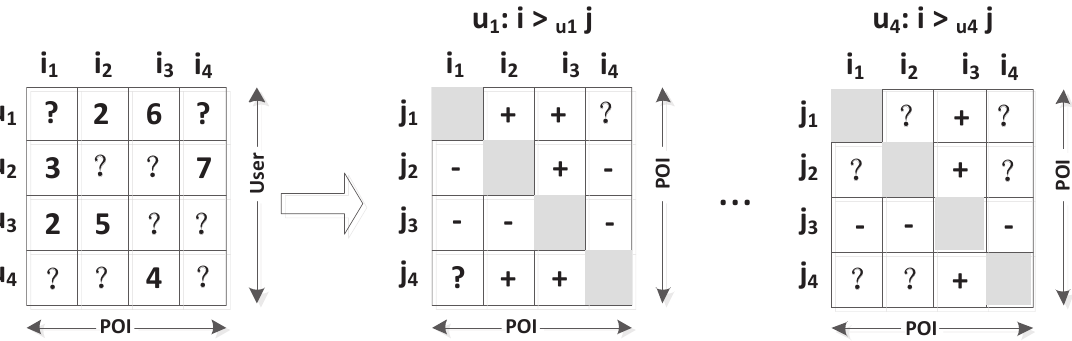
Figure 2. On the left side, the observed data R are shown. Our approach creates user-specific pairwise preferences i > u j between a pair of POIs. On the right side, a plus sign (+) indicates that a user prefers POI i over POI j ; a minus sign ( − ) indicates that a user prefers j over i